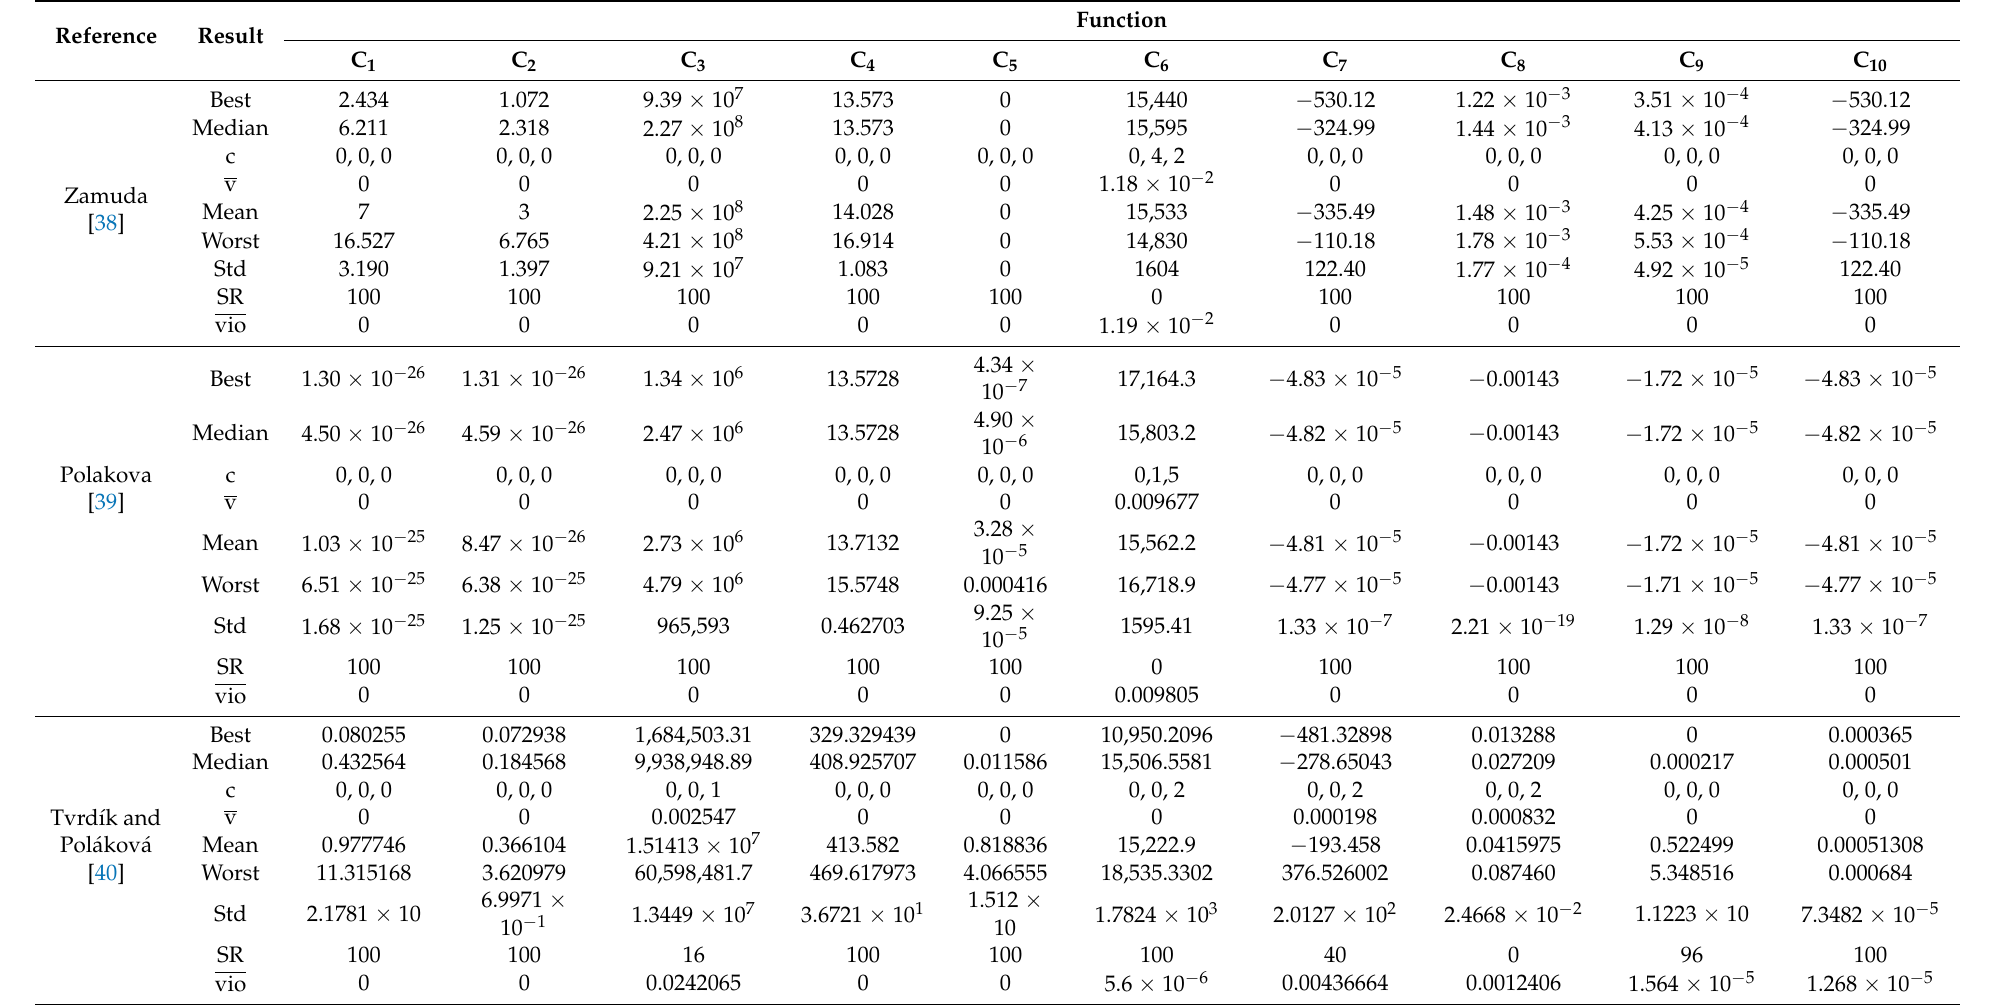
Table 7. Statistical results of different approaches for mathematical problems of CEC 2017 with 100